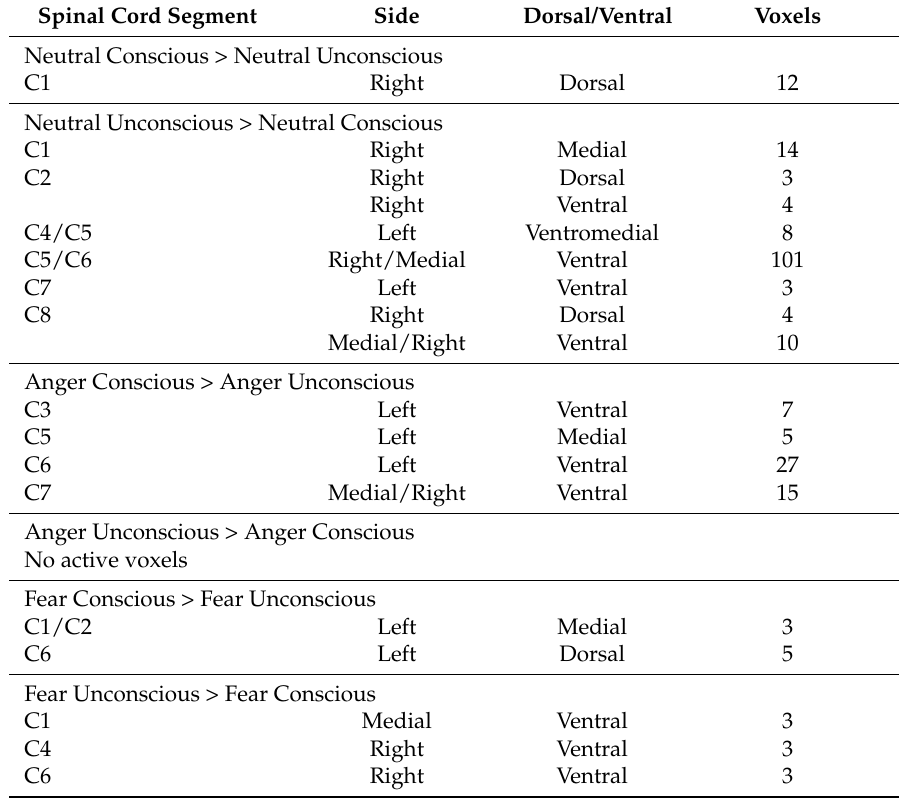
Table 1. Location of spinal cord activity in the contrasts of consciously and unconsciously perceived faces for each emotion. Results are presented at p < 0.0056; results containing 1 or 2 voxels have been excluded as they are likely false